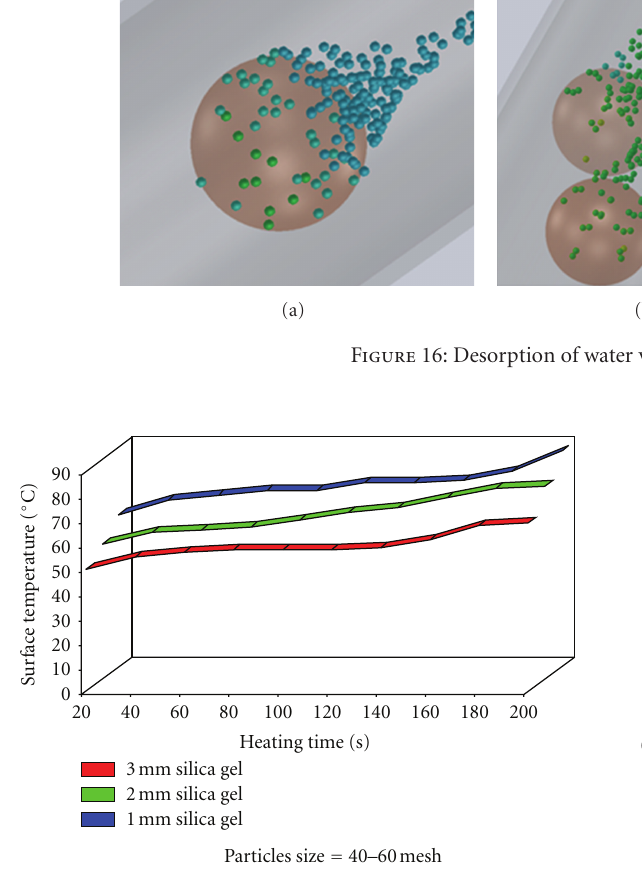
Figure 17: The variation of the surface temperature of silica gel size with the heating